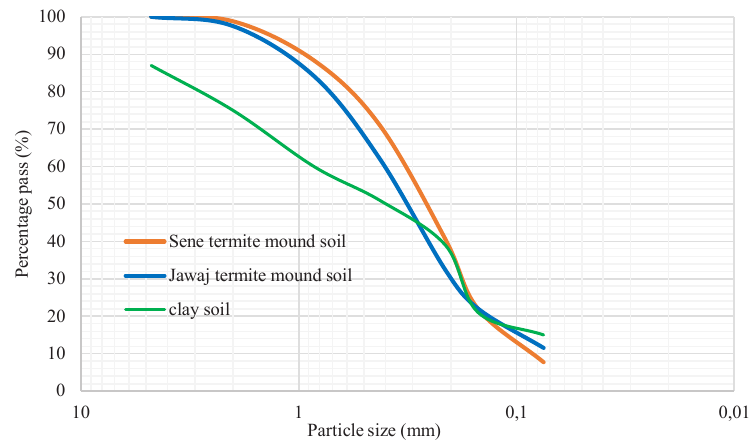
Figure 4: Particle size distribution curve.